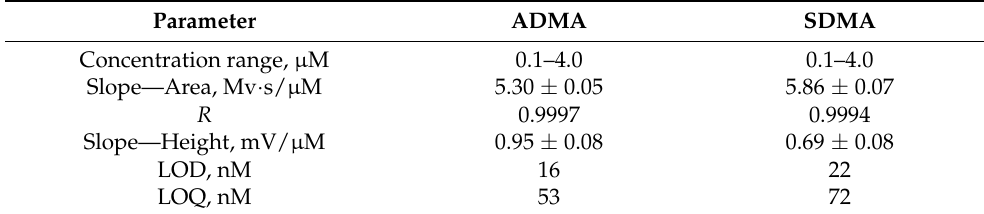
Table 1. Parameters of the calibration dependence for the determination of ADMA and SDMA in human plasma. Parameter ADMA